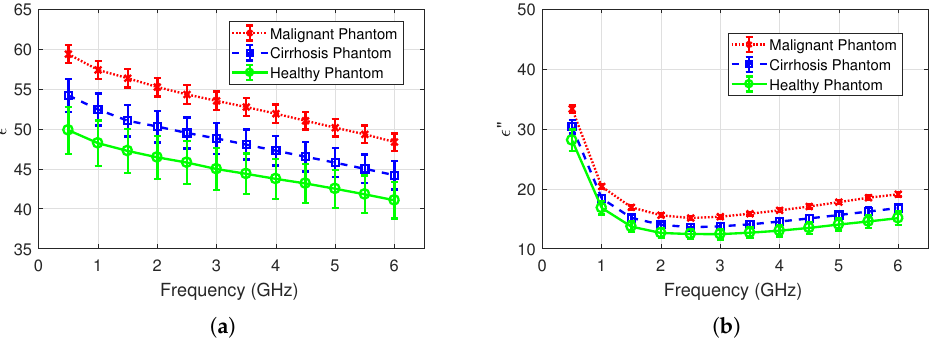
Figure 5. Measured dielectric properties of phantoms: ( a ) relative permittivity comparison of malignant, cirrhosis, andhealthyphantoms; ( b )dielectriclosscomparisonofmalignant, cirrhosis, andhealthyphantoms.